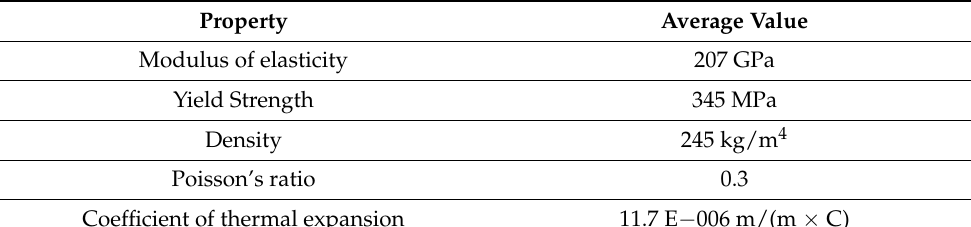
Table 1. Typical material properties of steel, used in computations.